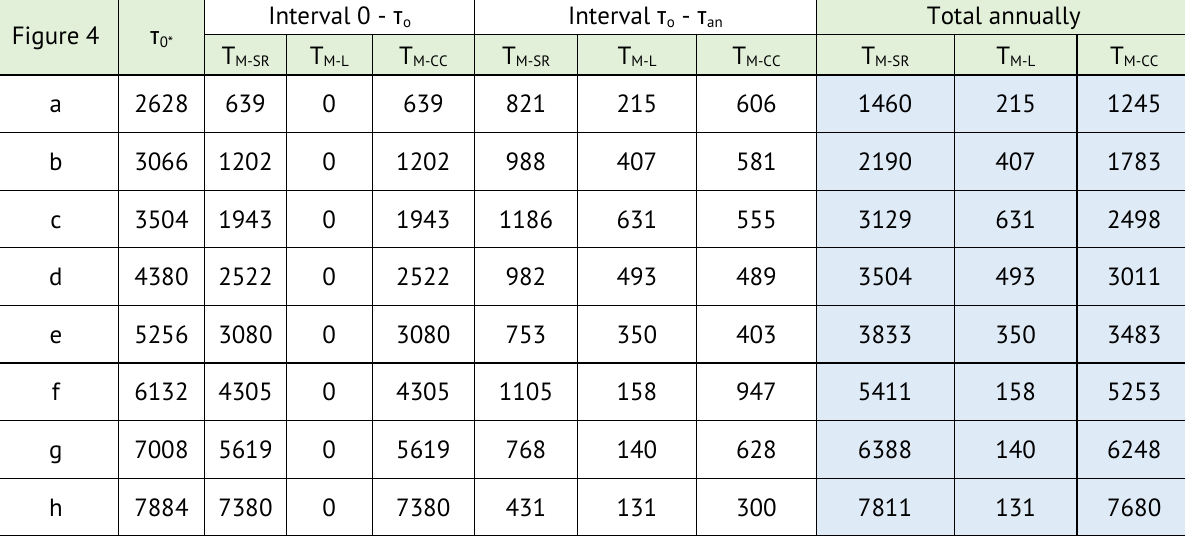
T and T determined for those two intervals, in h/yr M-SR, M-L M-CC